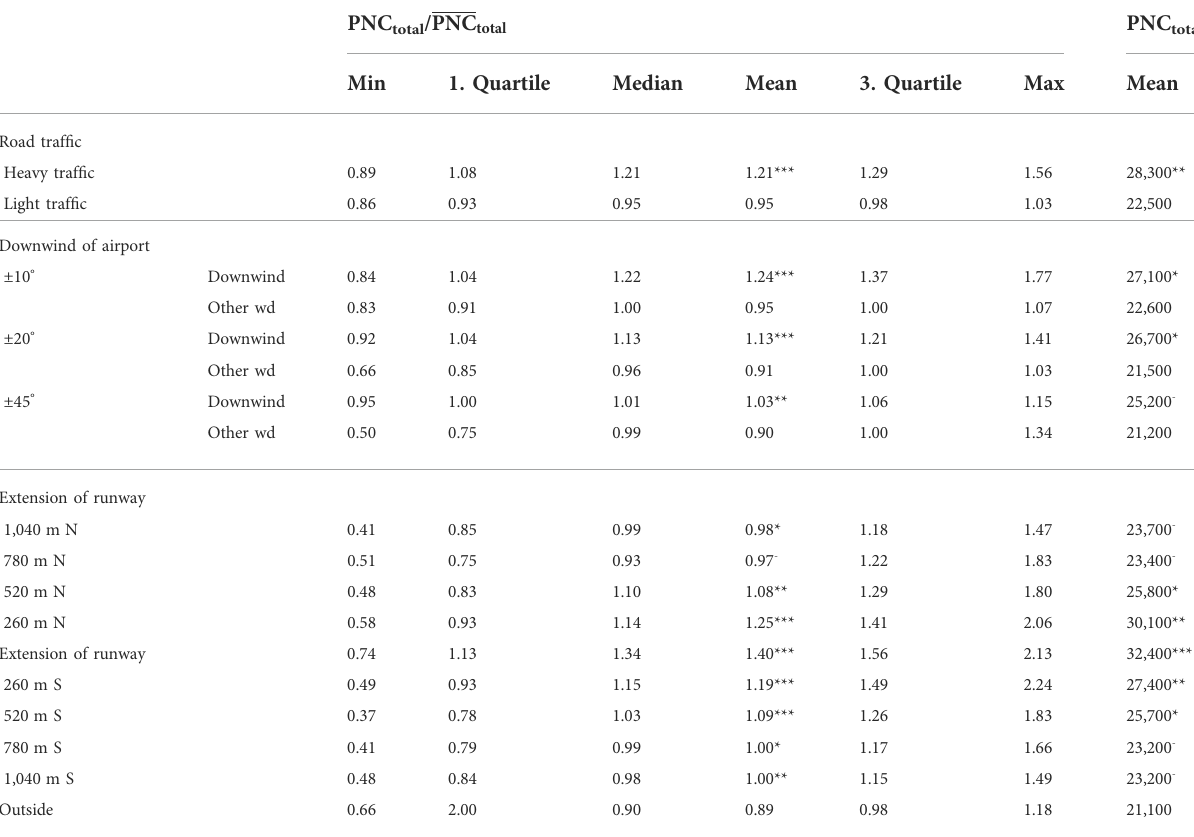
TABLE 3 Comparison of the impact of road traf fi c and airport variables on PNC total /PNC total and mean PNC total . Differences were analyzed using the t -test for heavy road traf fi c vs. light road traf fi c, areas downwind of the airport vs. those outside for the three angles α each, and for concentrationsofdifferentproximity totheextension of therunways (seeFigure1for illustration)vs.concentrationsoutsideofthegrayrectanglein Figure 1. PNC total /PNC